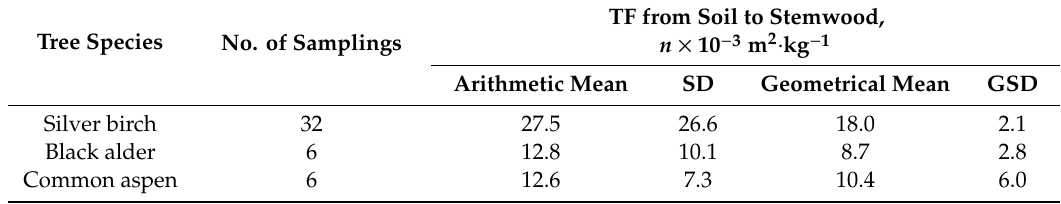
Table 5. Experimental data on estimated transfer factors (TFs) for 90 Sr (as of January 2018).